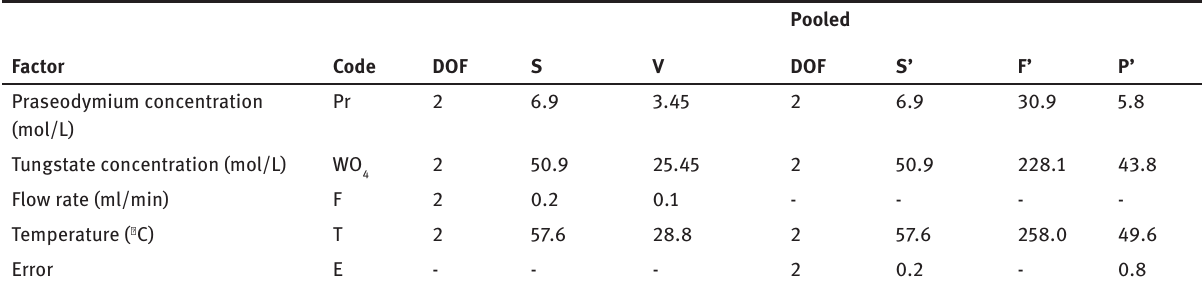
(WO ) plates (nm) are the 2 4 3